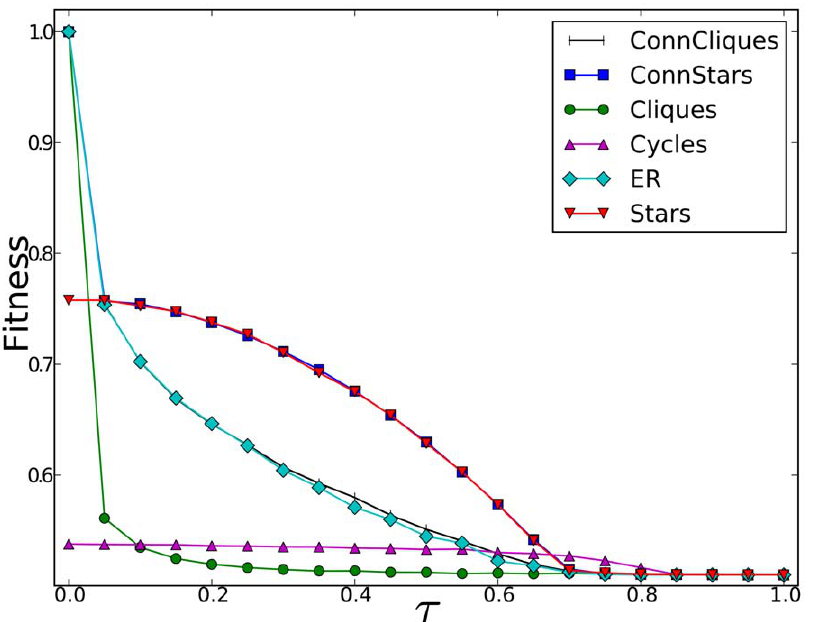
Figure 4. Fitness at r ~ 0 : 51 of various network designs. The Connected Stars design is the best design at all cascade risks, t . Cliques and Connected Cliques are competitive only for extreme ranges of t . The superiority of Connected Stars over the ER (random graph) confirms the hypothesis that cells give fitness gains against cascades. The fitness of a design at each value of t is defined as the fitness of the optimal configuration (network ensemble) within that design.